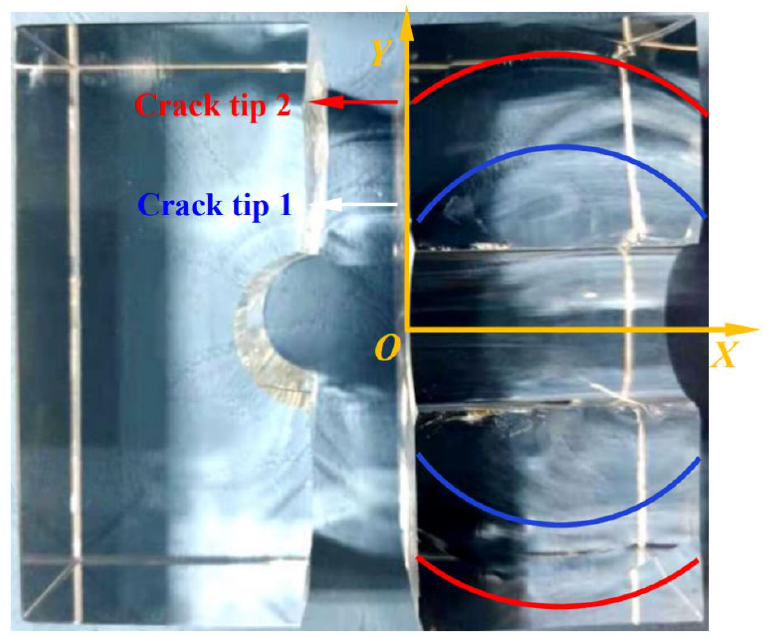
Figure 8. Arc propagation characteristics at crack tip.